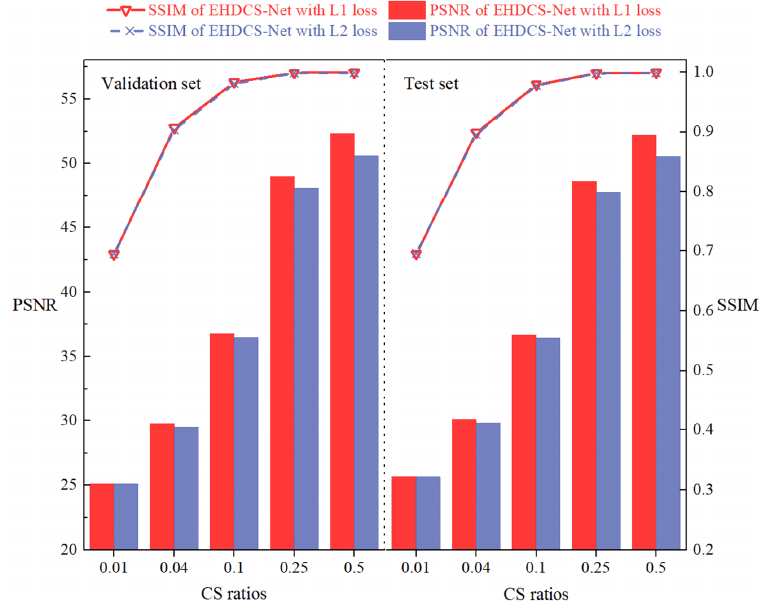
l loss and l 1 2